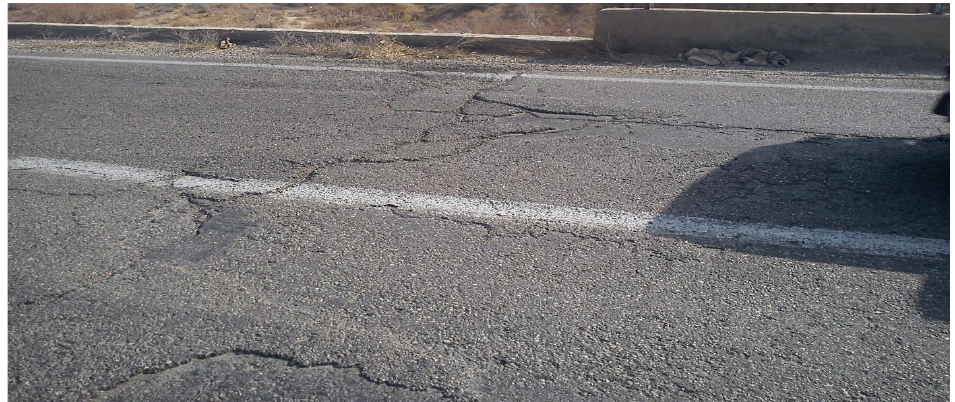
Figure 18. Safety and drainage issues in bridge No. 4.